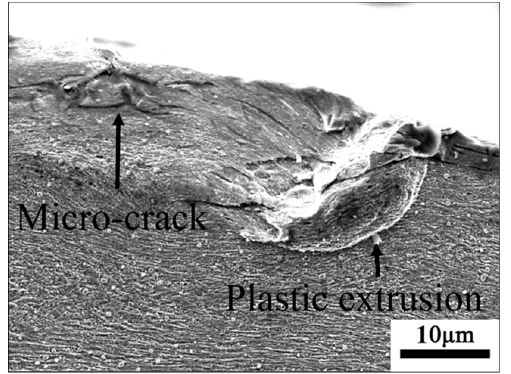
Figure 6. Cross-section morphology of the steel tempered at 680 °C after impact wear for 120 min.